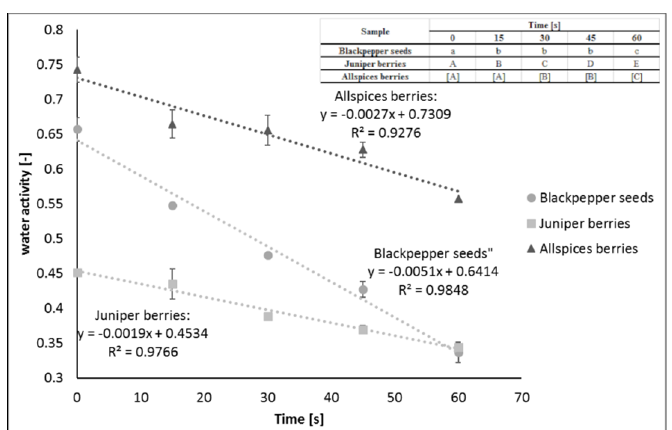
Figure 4. Water activity changes after plasma treatment. Significant differences between investigated samples, based on the Tukey test results, are indicated by different small letters (a, b, c…), capital letters (A, B, C…) or capital letters in brackets ([A], [B], [C]…) for different spice species (black pepper seeds, juniper berries and allspices berries, respectively). n = 3.